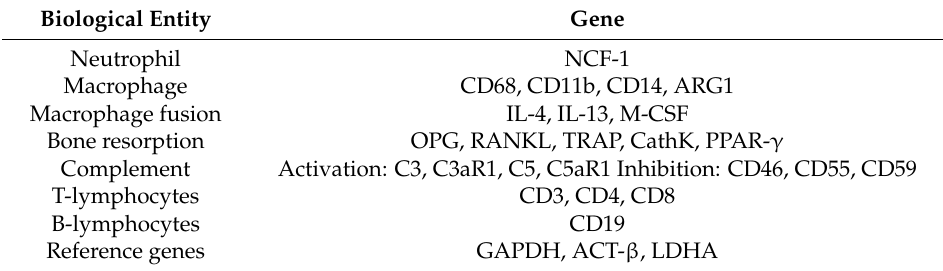
Table 2. Correspondence between studied gene expression and biological